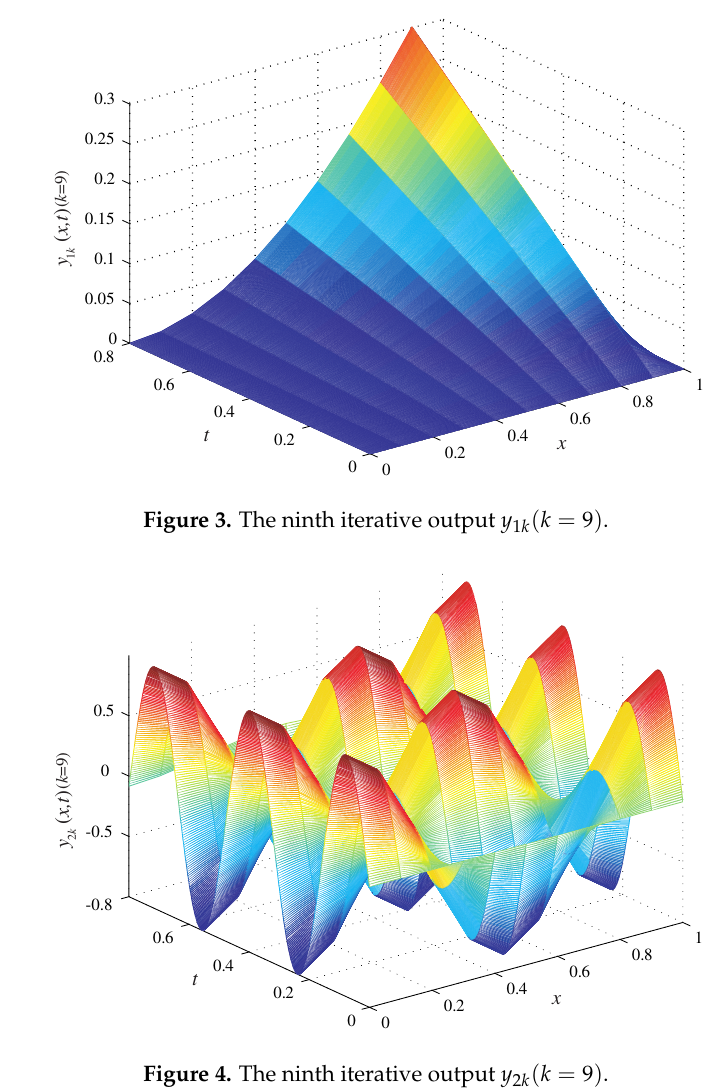
Figure 4. The ninth iterative output y 2 k ( k = 9 )